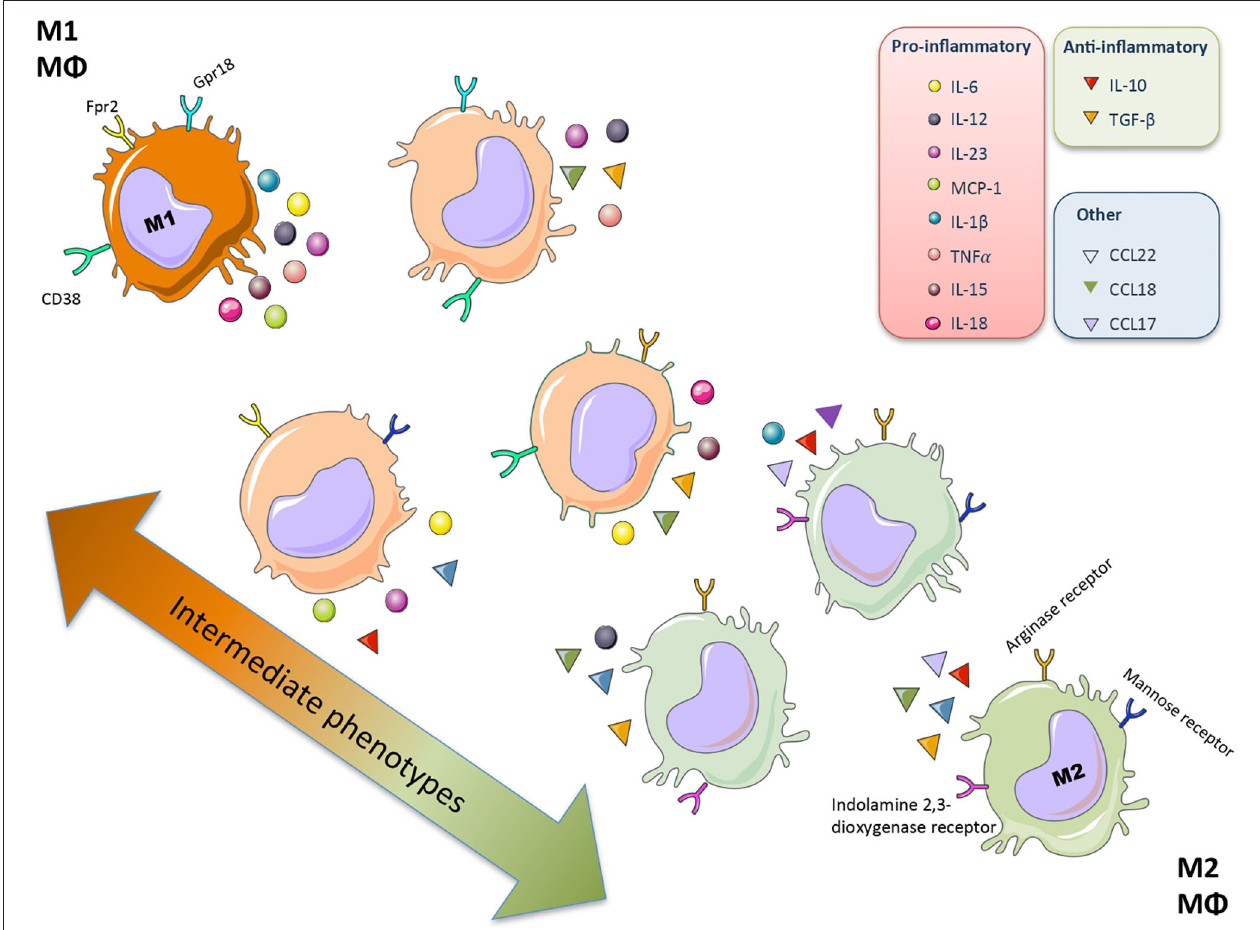
FIGURE 1 | Macrophage polarization. Macrophages (M θ ) have a great plasticity and have different functional activation states and phenotypes that allow different specialized functions. The macrophage population represents a continuous phenotype ranging between M1/M2 extremes, characterized by a specific secretome (mainly cytokine and chemokines) and surface